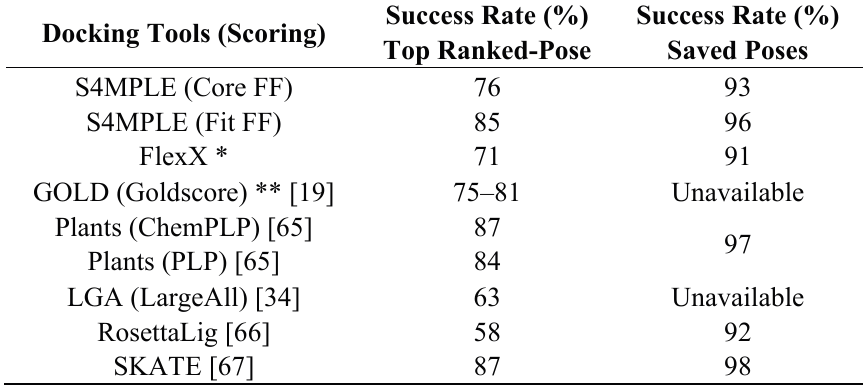
Table 4. Docking performance of several tools on the Astex Diverse Set (* Result from herein described benchmarking calculations, ** Statistics from closest protocols with respect to those presented here). With S4MPLE, Saved poses include the top 30 non-redundant (at minfpdiff = 0.01 ) most stable